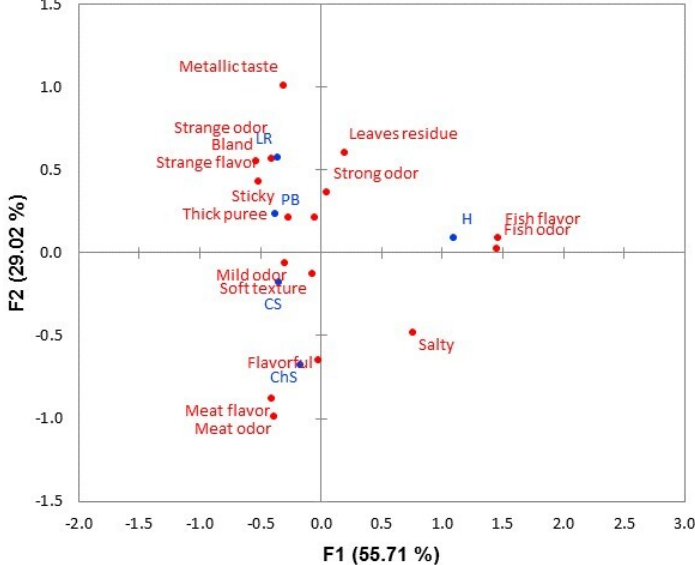
Figure 1. Symmetric graph of attributes and dishes (obtained by multiple correspondence analysis) for the sensory differences between texture-modified dishes to CP dysphagia. Dishes: chickpea stew (CS), lentils with rice (LR), chicken stew (ChS), halibut with green sauce (H), and pasta bolognese (PB).